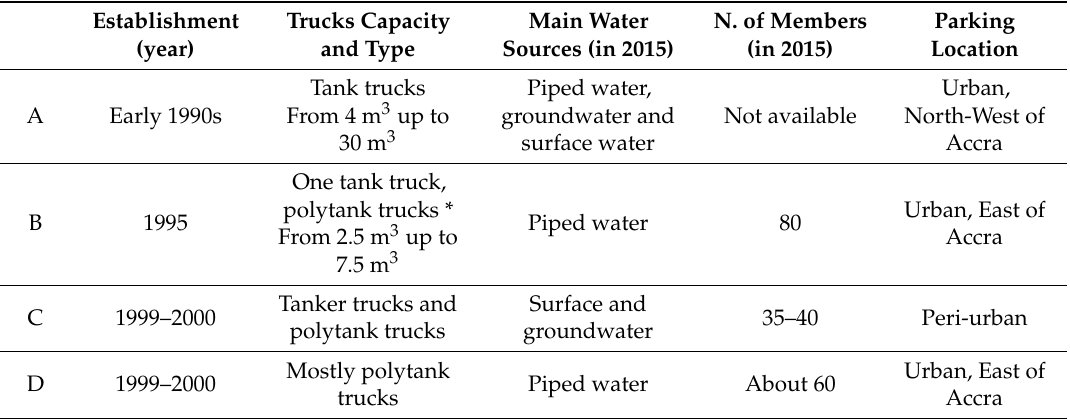
Table 1. Main characteristics of tanker water associations involved in the study. Source: authors’ fieldnotes, 2015.